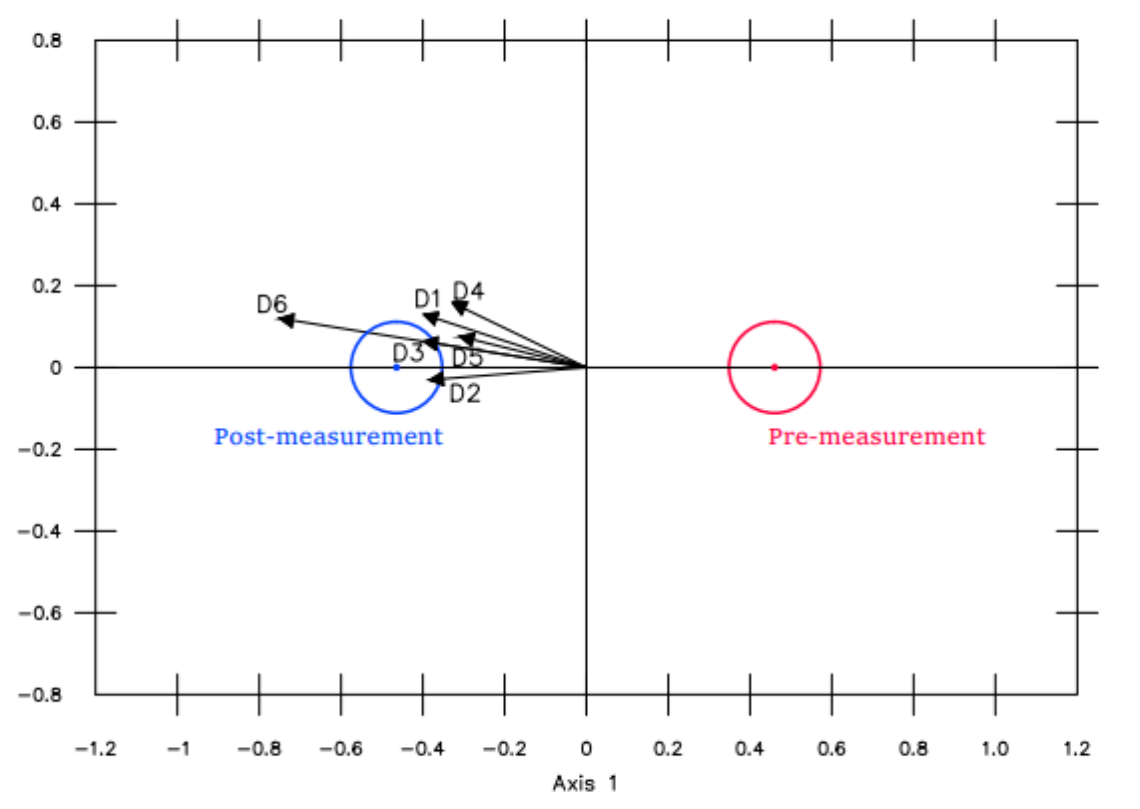
Figure 2. MANOVA Biplot pre- vs. post-measurement.